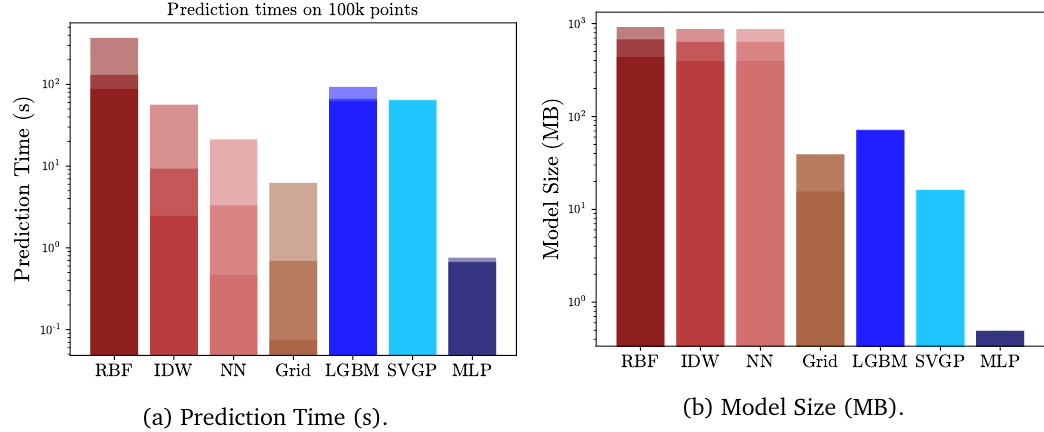
Figure 16: The prediction times on 100k testing points in seconds (left) and the file size of each approximant in megabytes